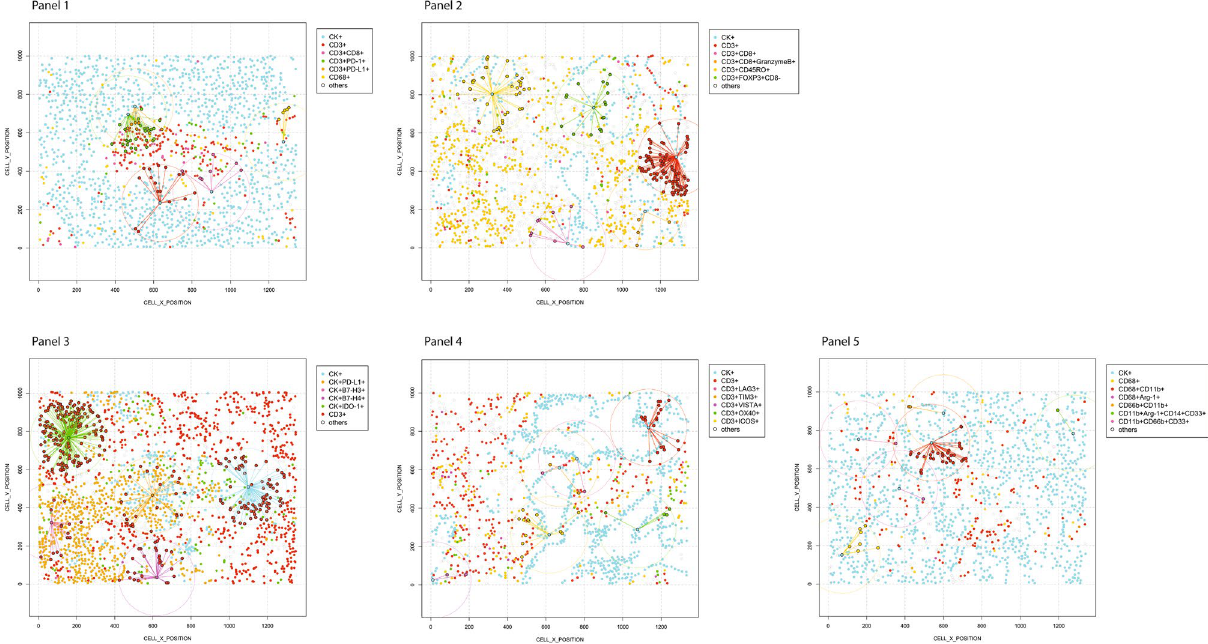
Figure 5. Spatial analysis showing (panels 1 and 2) representative examples of distance measurements from CK+ malignant cells ( cyan dots ) to different CD3+T-cell phenotypes ( identified by different colored dots according the marker’s expression ) and CD68+ macrophages ( yellow dots ); (panel 3) representative examples of distance measurements from CK+ malignant cells expressing different immune checkpoint markers (PD-L1, B7-H3, B7-H4, and IDO-1, identified by different colored dots ) to CD3+T-cells ( red dots ); (panel 4) representative examples of distance measurements from CK+ malignant cells to CD3+T-cells expressing different immune checkpoint markers (LAG-3, TIM3, VISTA, OX40, and ICOS); and (panel 5) representative examples of distance measurements from CK+ malignant cells to different CD68+ macrophage phenotypes and other myeloid suppressor cell phenotypes using the X and Y coordinates with a radius of 200 microns ( circles ). The images were generated using R studio software version 3.6.1.